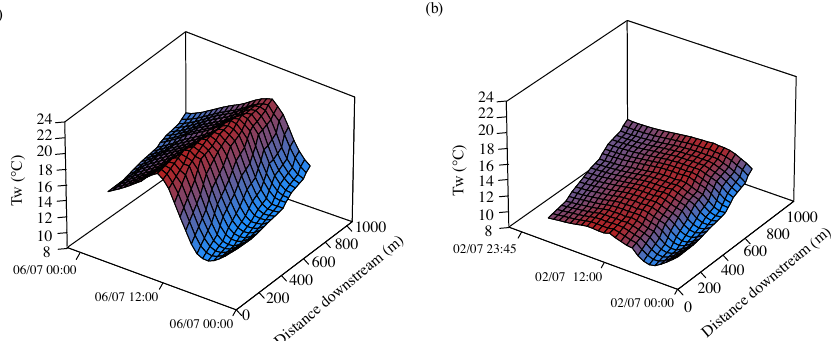
Figure 9. Temperature of water parcels (black lines on the date and time axis) routed through the reach from AWS Open at hourly intervals (a) on day 6 and (b) day